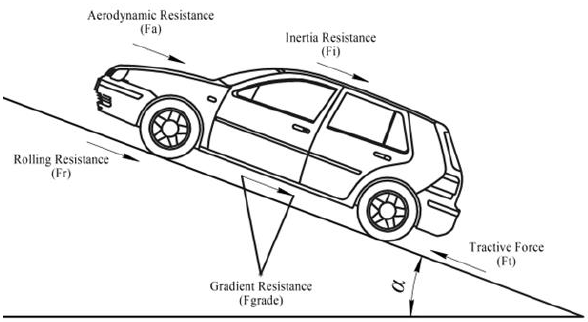
Fig. 3. Forces distribution under longitudinal motion